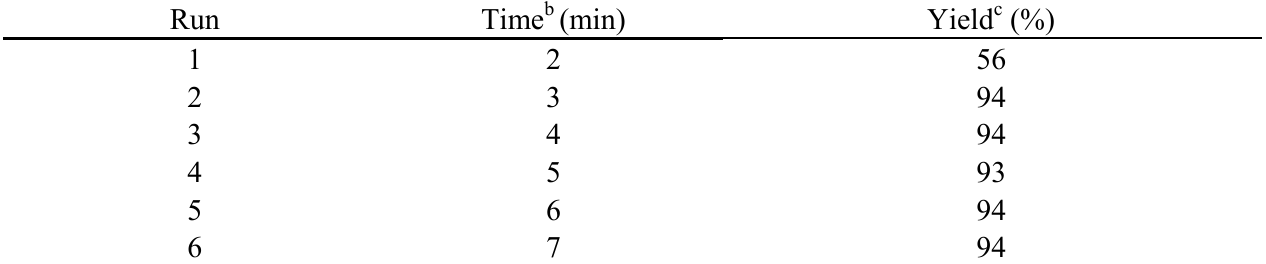
Table 3. Optimization of the reaction time for the synthesis of ethyl ferulate ( 3b ) a